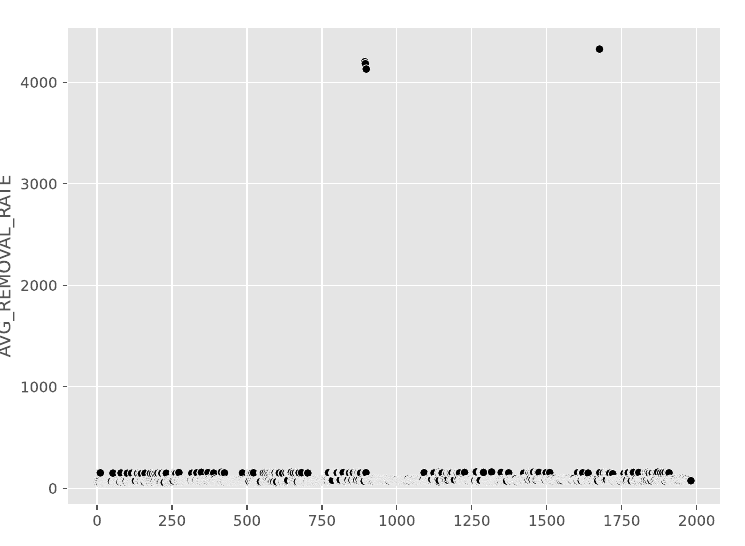
Figure 3. Outlier Detection with Data